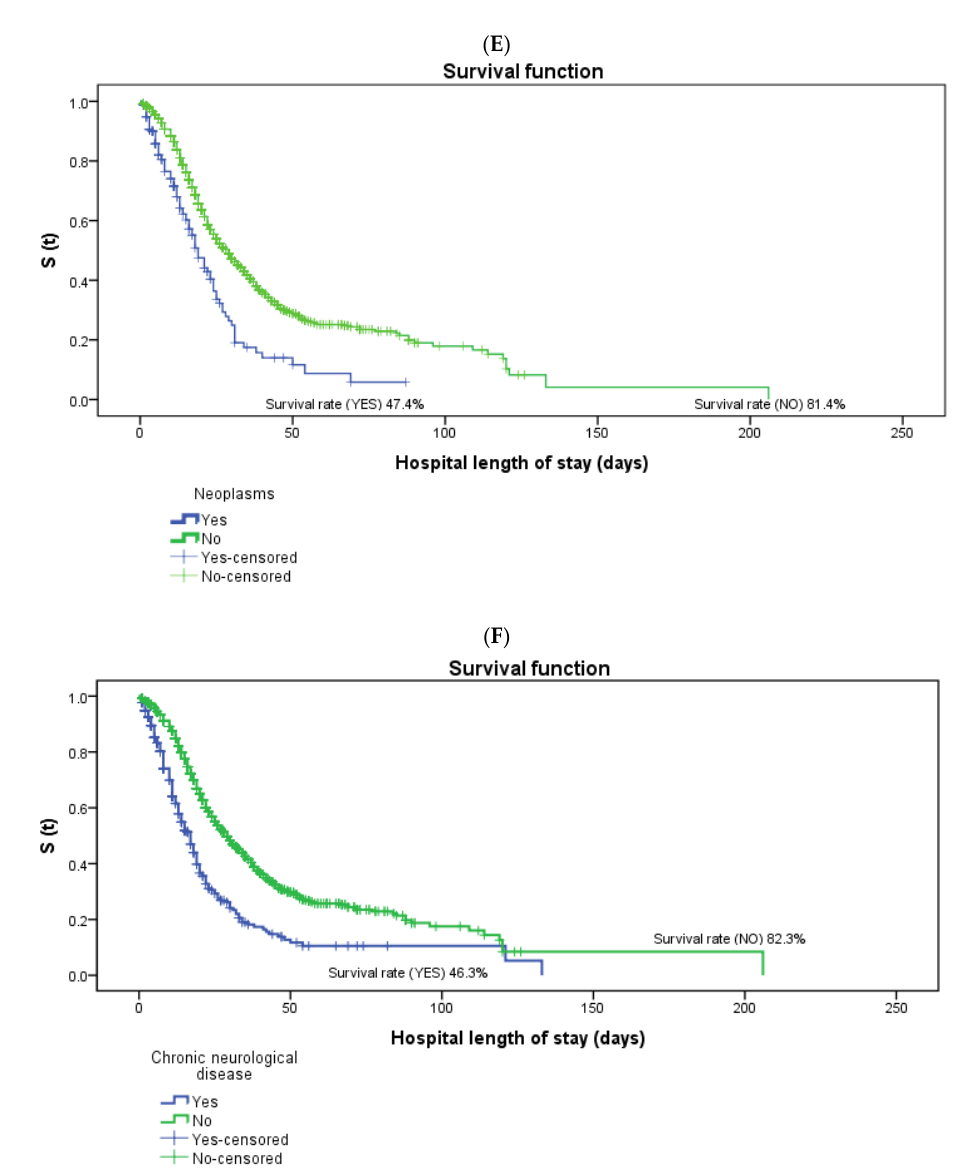
Figure 3. Survival curves of patients hospitalized with COVID-19 in Esp í rito Santo, Brazil. Log-rank test was used for comparison of equality of survival curves of clinical variables in the period from 1 March 2020 to 31 July 2021. ( A ) Survival function according to the hospital length of stay of patients hospitalized with COVID-19 in Esp í rito Santo, Brazil, according to the independent variable chronic cardiovascular disease. ( B ) Survival function according to the hospital length of stay of patients hospitalized with COVID-19 in Esp í rito Santo, Brazil, according to the independent variable chronic kidney disease. ( C ) Survival function according to the hospital length of stay of patients hospitalized with COVID-19 in Esp í rito Santo, Brazil, according to the independent variable smoking. ( D ) Survival function according to the hospital length of stay of patients hospitalized with COVID-19 in Esp í rito Santo, Brazil, according to the independent variable obesity. ( E ) Survival function according to the hospital length of stay of patients hospitalized with COVID-19 in Esp í rito Santo, Brazil, according to the independent variable neoplasms. ( F ) Survival function according to the hospital length of stay of patients hospitalized with COVID-19 in Esp í rito Santo, Brazil, according to the independent variable chronic neurological disease.